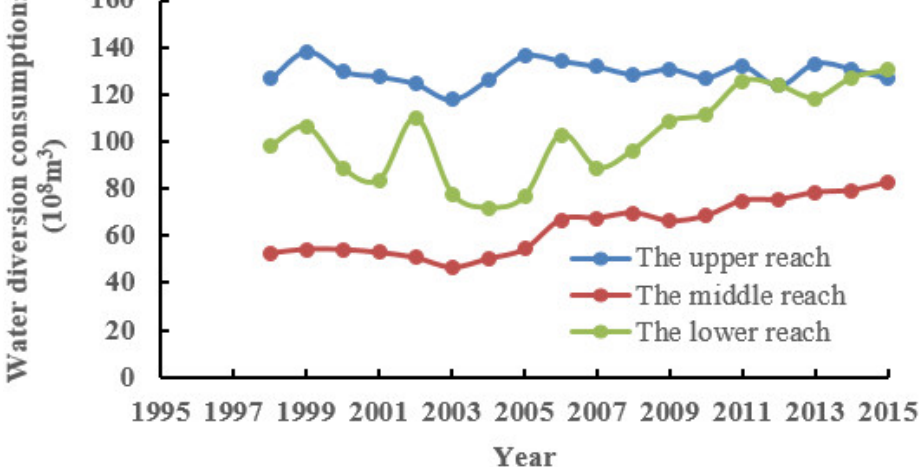
Figure 15. Variations of water diversion consumes at the upper, middle and lower of along the Yellow River.